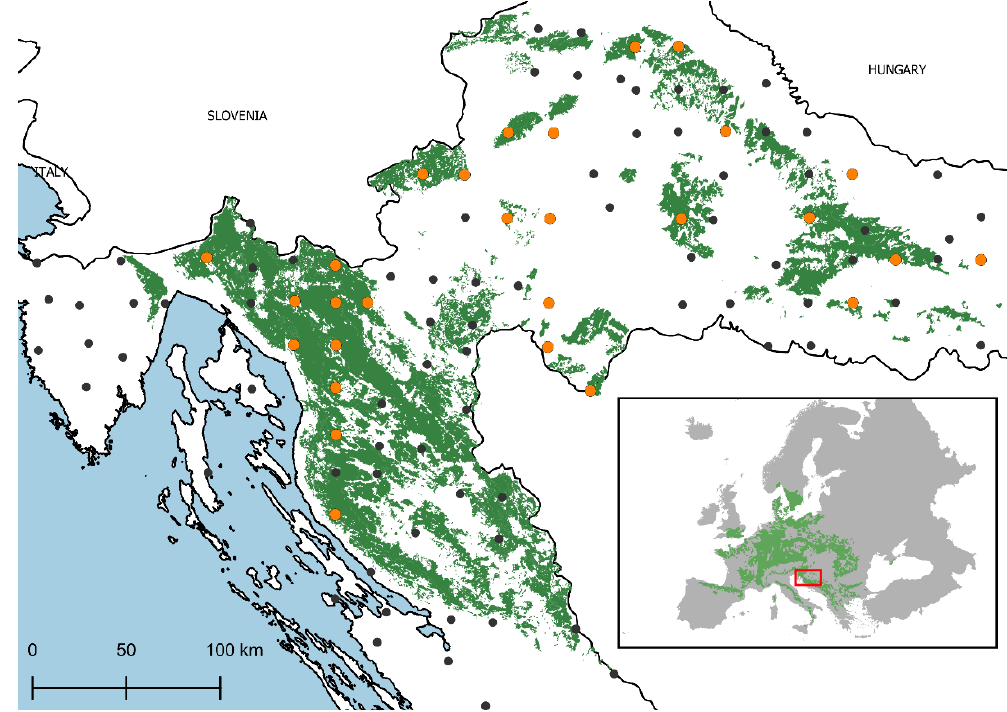
Figure 3. Location of research plots in the context of the distribution of European beech in Europe [66]. Selected Level I ICP Forests monitoring plots (orange dots); remaining Level I plots in Croatian (black dots); distribution of European beech forests in Croatia [67] (green polygon).